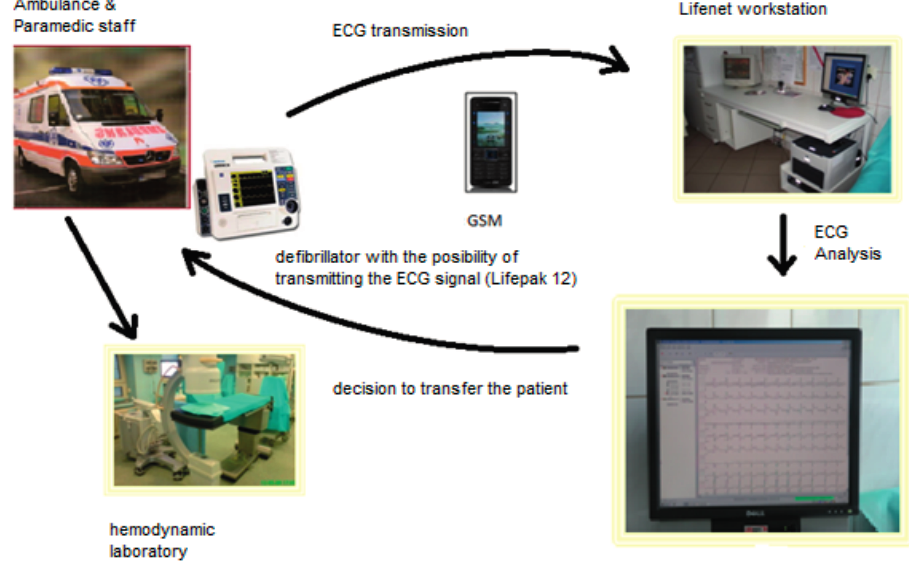
Figure 1. Teletransmission system in Poland. The ambulance team performs ECG using a Lifepack 12 defibrillator. Then, using the mobile station they transmit a record via